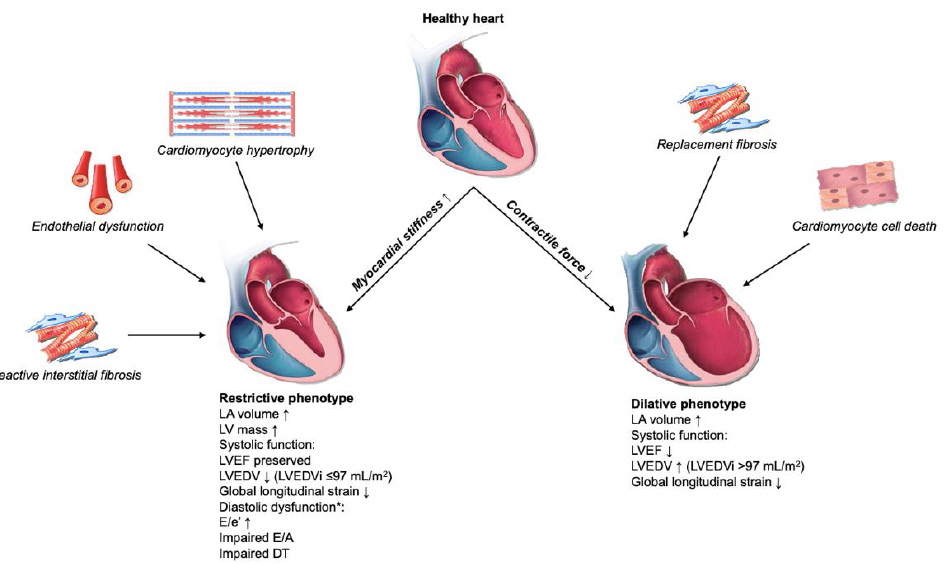
Figure 3. Echocardiographic landmarks of different diabetic cardiomyopathy phenotypes with associated pathophysiologic pathways. Abbreviations: LA: left atrium; LV: left ventricle; LVEF: left ventricular ejection fraction; LVEDV: left ventricular end-diastolic volume; LVEDVi: left ventricular end-diastolic volume index; DT: deceleration time. * E/e’ is increased in most patients, whereas E/A and DT depend on severity of diastolic dysfunction. For instance, Grade I diastolic dysfunction results in reduced E/A ratio, and Grade II and III with normal to high E/A ratio.